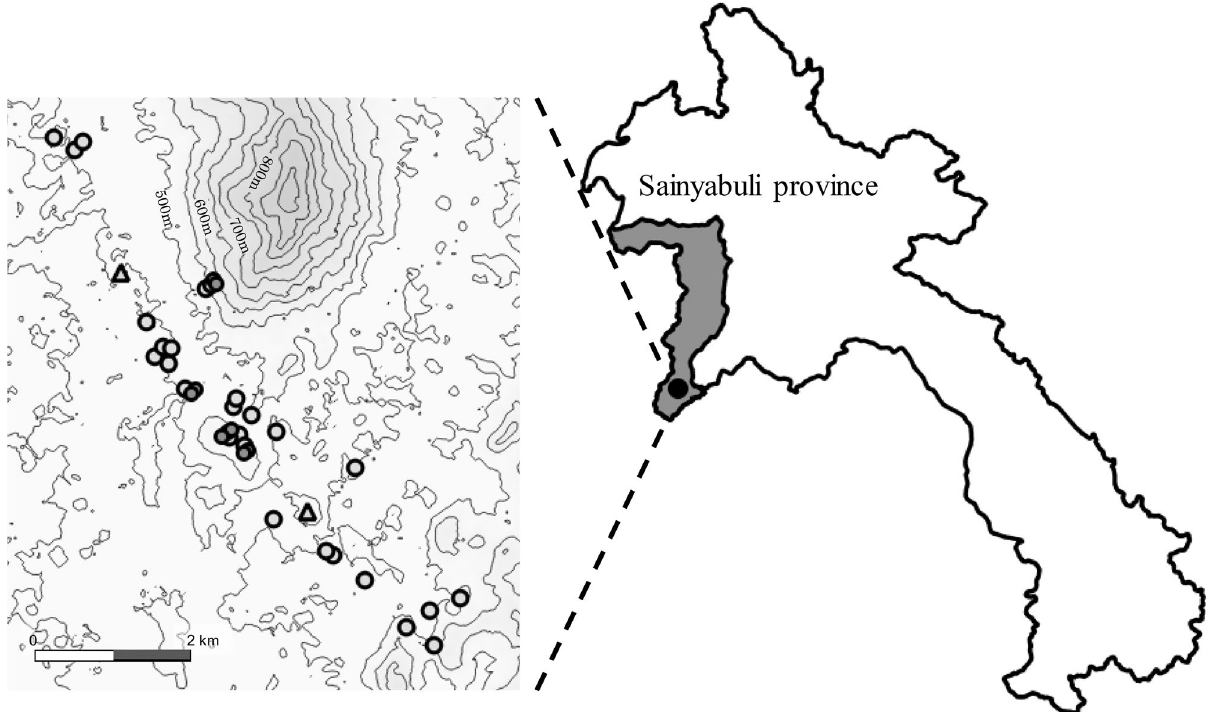
Figure 1. Map of the study area, including the investigation fields and villages in Kenthao District, Sainyabuli Province. The open and closed dircle symbols represent the investigated maize fields and the non-cultivation fields, respectively. The triangles symbols represent the